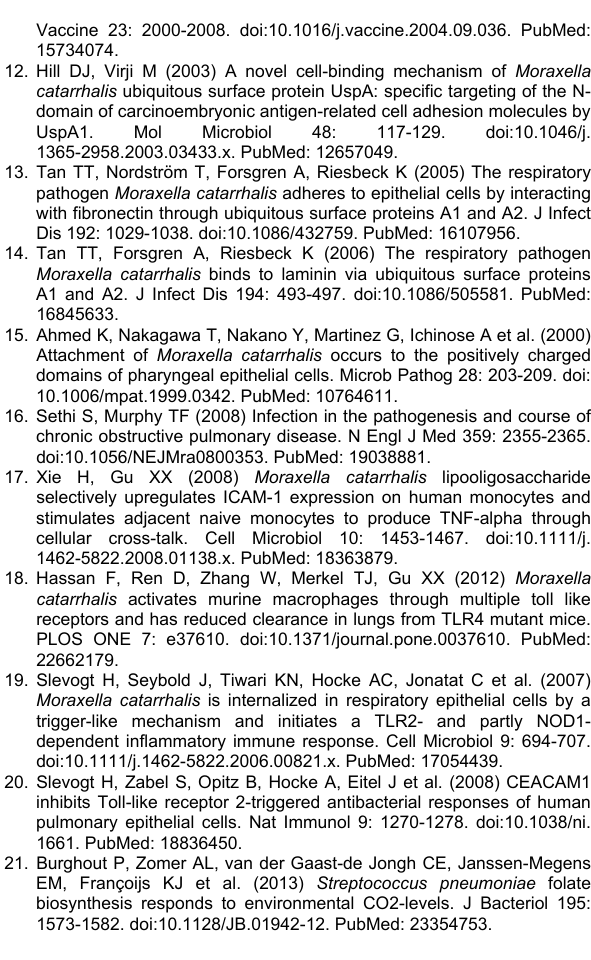
Table S2. Genes differentially expressed in Detroit 562- attached M. catarrhalis BBH18.